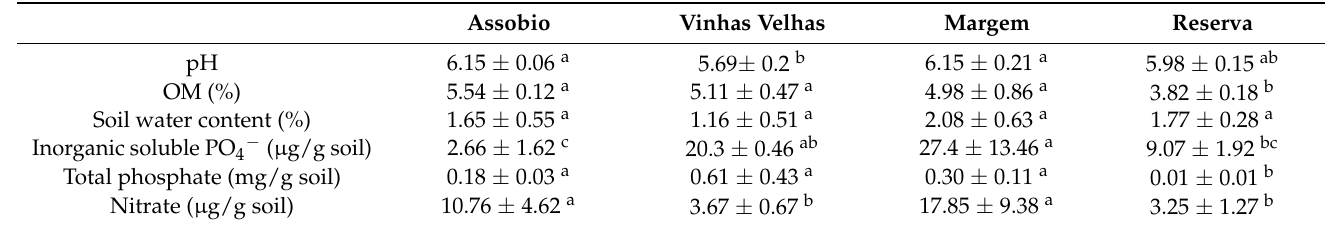
Table 2. Mean and standard deviation values for each of the soil physicochemical parameters analysed for Assobio, Vinhas Velhas, Margem and Reserva. Different letters indicate statistically significant differences between the terroirs, considering p < 0.05 (n =